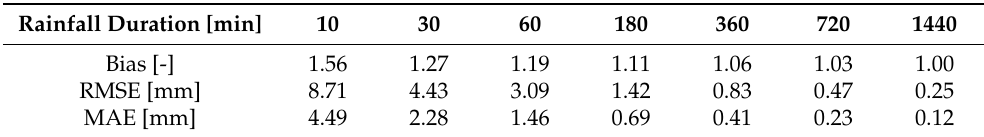
Table 1. Bias, root mean square error (RMSE) and mean absolute error (MAE) for all investigated rainfall